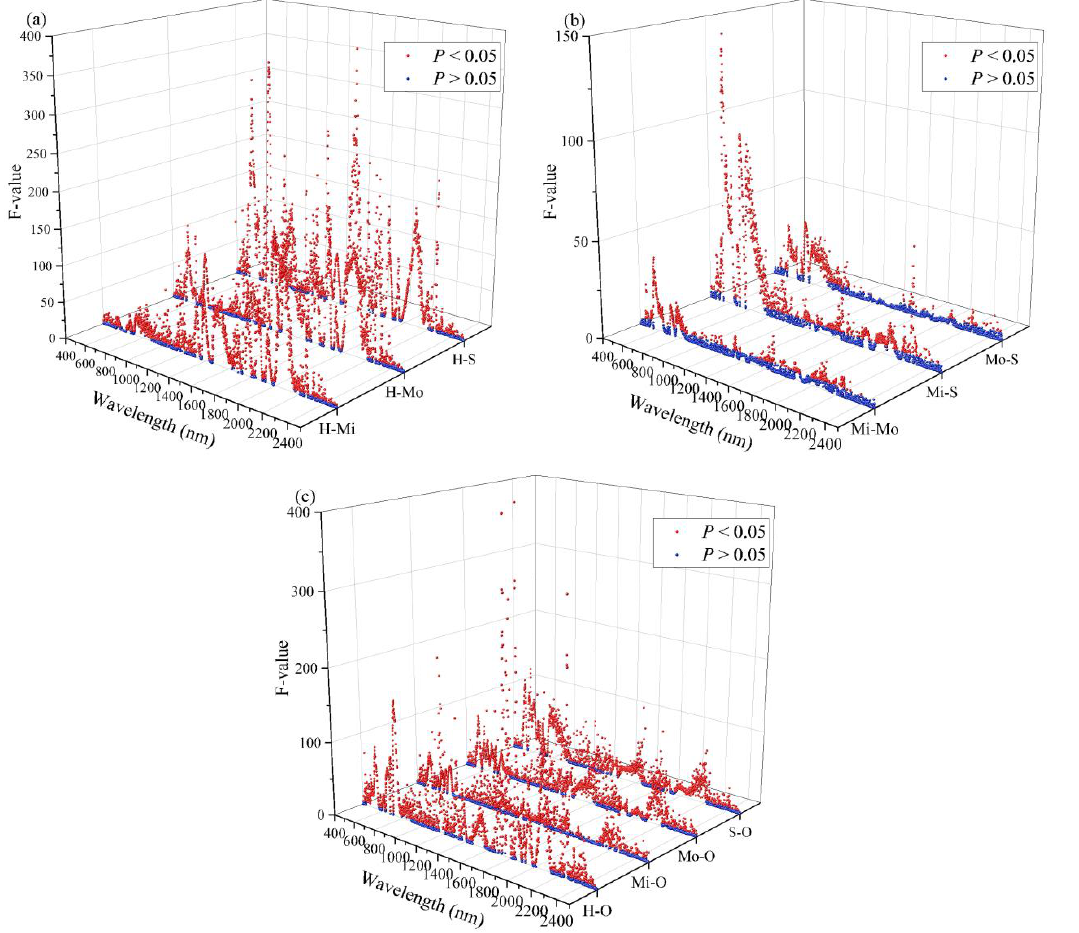
Figure 9. One-way ANOVA of spectral wavelengths among different Moso bamboo leaf states: ( a ) one-way ANOVA of the H and damaged (Mi, Mo, S) states; ( b ) one-way ANOVA of different damage states; ( c ) one-way ANOVA of off-year and on-year (H, Mi, Mo, S) states.